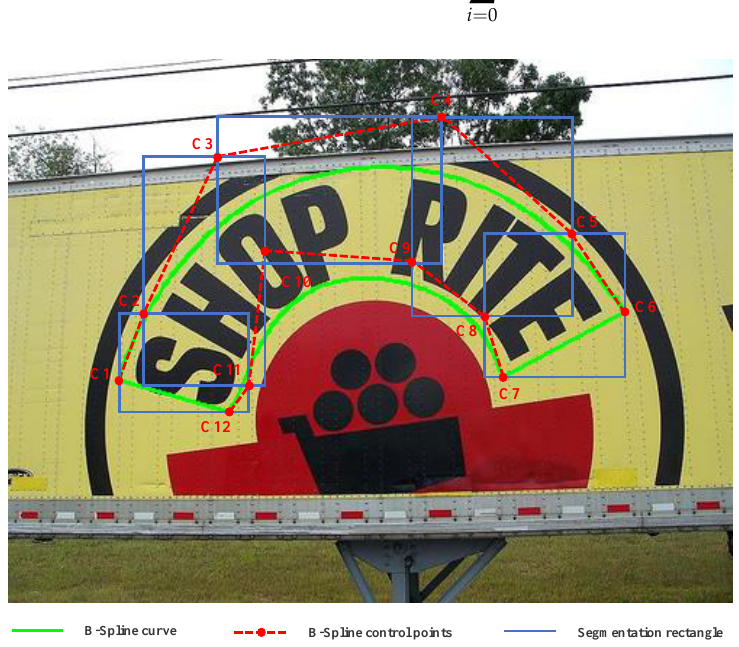
Figure 4. Example of segmentation rectangle